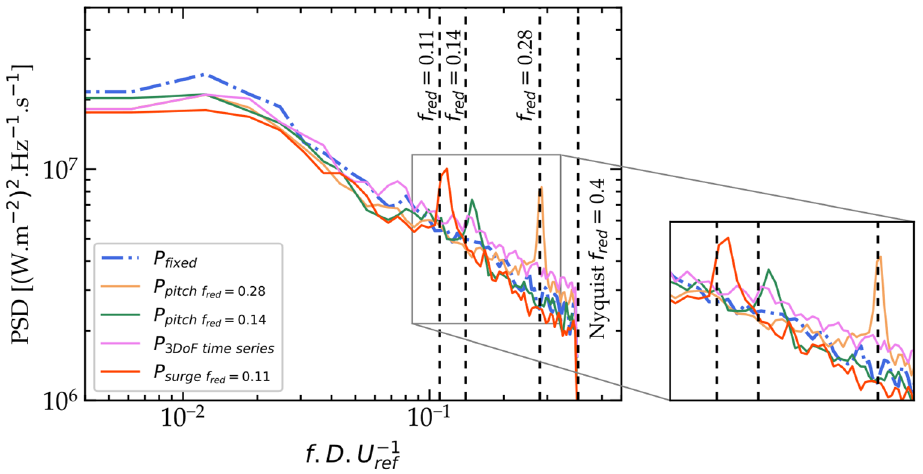
Figure 13. Power spectrum density (PSD) of porous disc wake power, measured at x = 8.125 D.